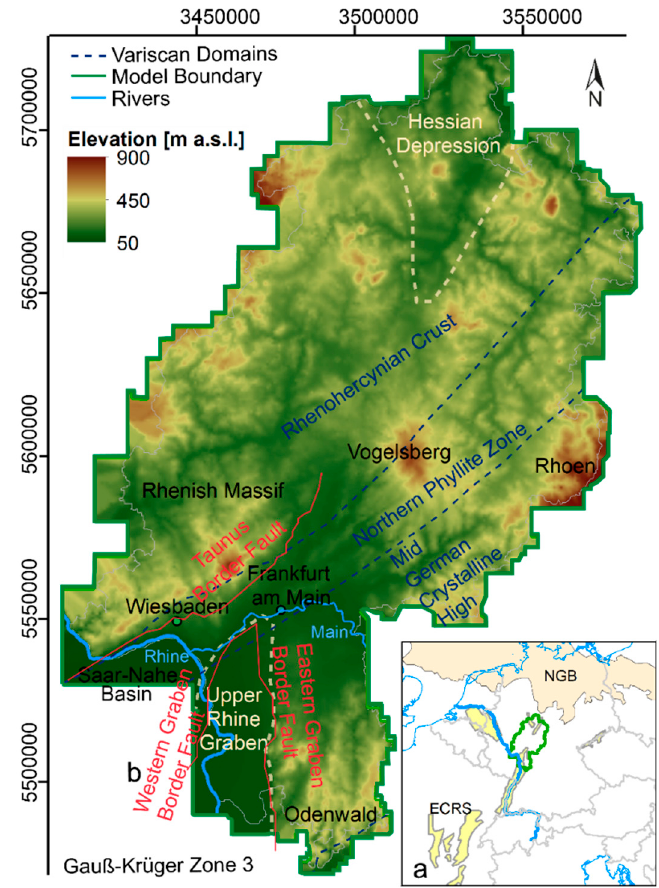
Figure 1. ( a ) Position of the model area marked by a green contour, the sediments of the European Cenozoic Rift System (ECRS) in yellow and of the North German Basin (NGB) in orange; ( b ) topographic map of Hesse with high regions of Rhenish Massif, Vogelsberg, Rhoen and Odenwald and thick sedimentary deposits of Hessian Depression and Upper Rhine Graben with dashed beige lines. In red, three important main faults at the surface are outlined (modified after Arntd et al. [32]).